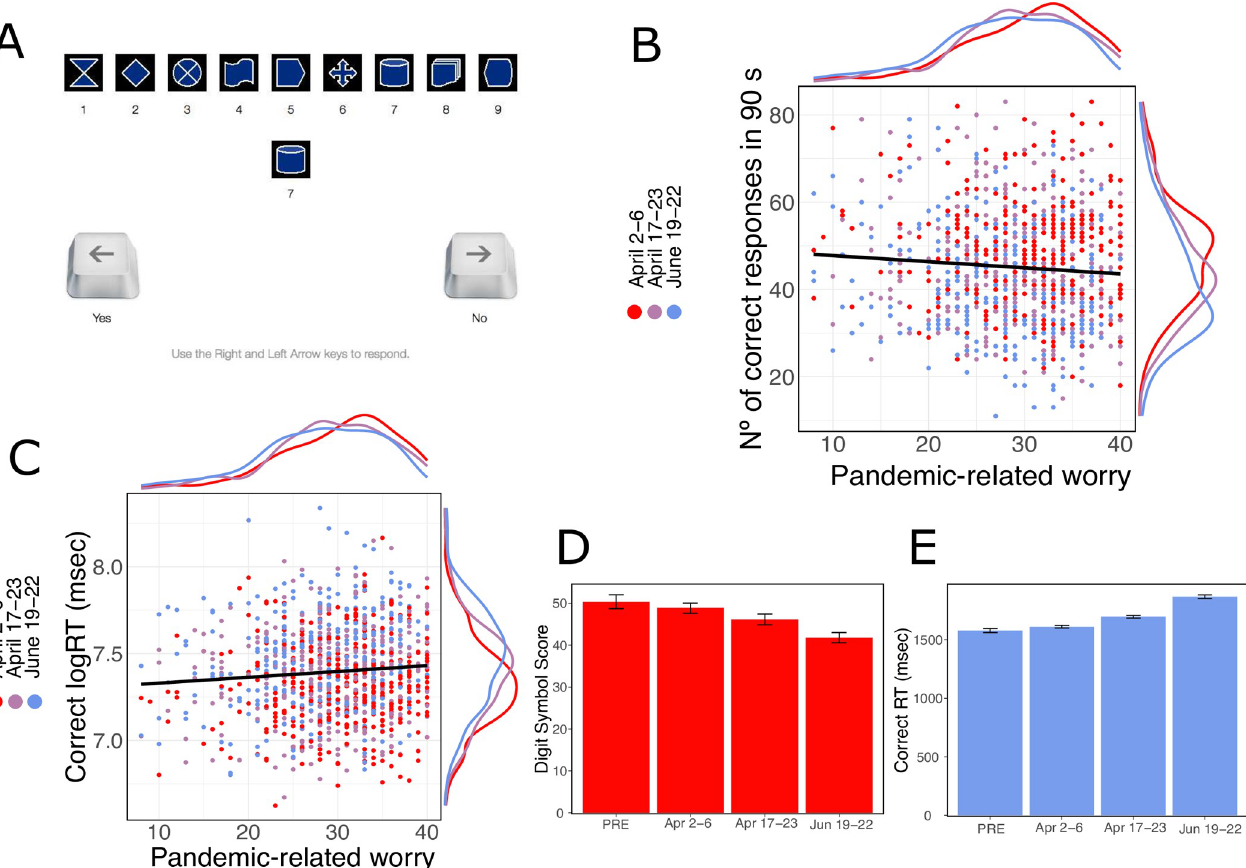
Fig 2. Participants’ performance on the digit-symbol coding task. A. Screenshot of the Digit symbol-coding task. B. We observed a relationship between FCQ scores and Digit Symbol-Score ( β = -0.940, CI = [-1.591, -0.289], p = .005); here plotted with the marginal distribution of the ordinate and abscissa C. We also observed a relationship between FCQ scores and log correct RTs ( β = 0.019, CI = [0.005, 0.033], p = .009); again, plotted with the marginal distribution of the ordinate and abscissa. D. Processing Speed decreased in comparison to the pre-pandemic sample and by wave (p’s < .05;); here plotted by wave with 95% bootstrapped confidence interval. E. Participants’ response times increased in comparison to the pre-pandemic sample and by wave (p’s < .05); again, plotted here with 95% bootstrapped confidence intervals.